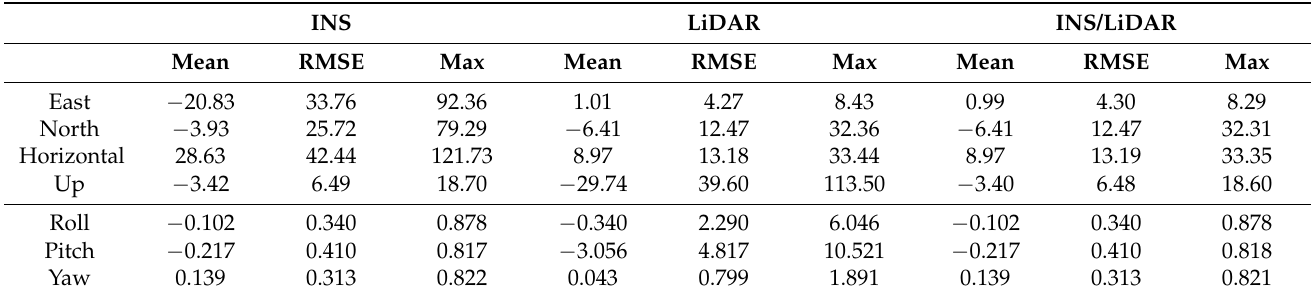
Table 7. D-42—GNSS-assisted—position (m) and attitude (deg) error statistics.